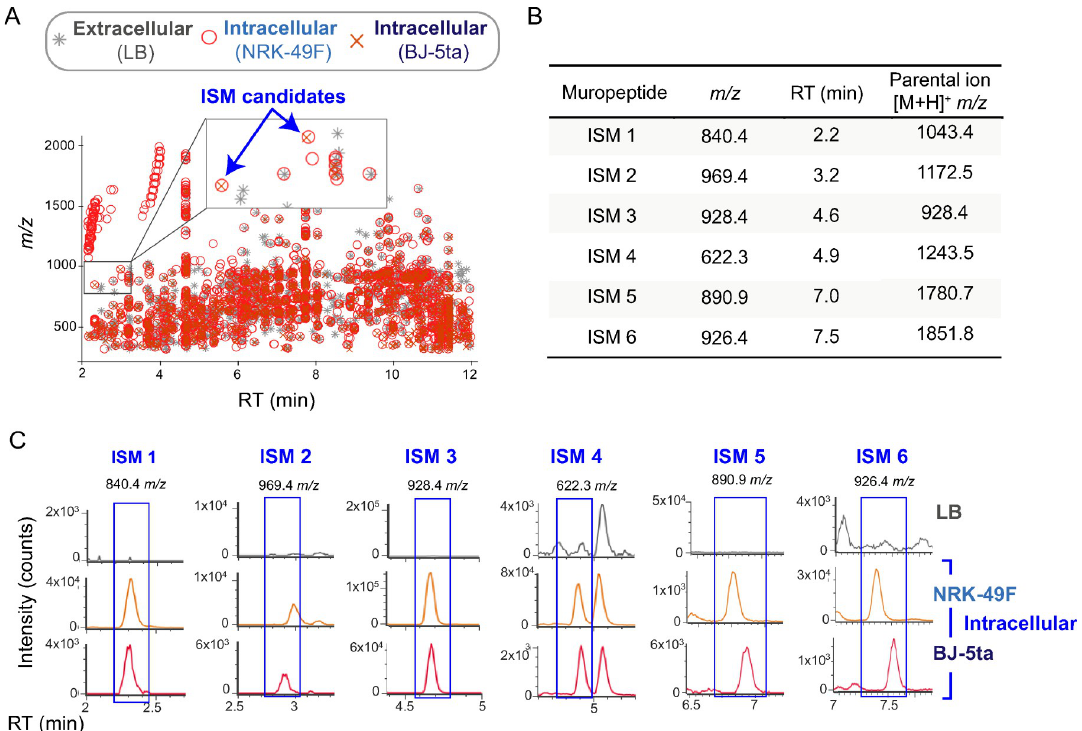
Fig 1. Comparative untargeted MS analysis of PG isolated from S . Typhimurium growing in extracellular and intracellular conditions. (A) Chart used for selection of Intracellular- Salmonella Muropeptide (ISM) candidates showing the m/z values obtained by untargeted MS and their corresponding retention time (RT) of the indicated samples. (B, C) ISM candidates enriched in PG samples of intracellular bacteria that were confirmed by comparative ion chromatographic analyses.